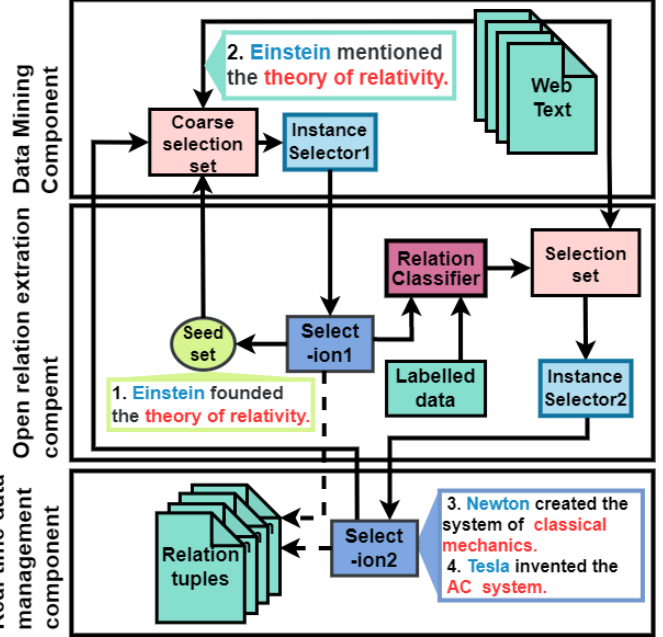
Figure 3. The framework of ORES and internal components’ structure, along with some examples during one iteration. ORES includes 3 components to achieve different functions. Instance selector 1 is the core structure of the data mining component to filter Web text information. ORES’s core model is a relation classifier which can extract increasing relation facts. Web texts are the input and relation tuples are ORES’s outputs. There are 4 sentences. The first one is one of seed samples. The second sentence is mined by distant supervision. The third and the fourth are ORES’s